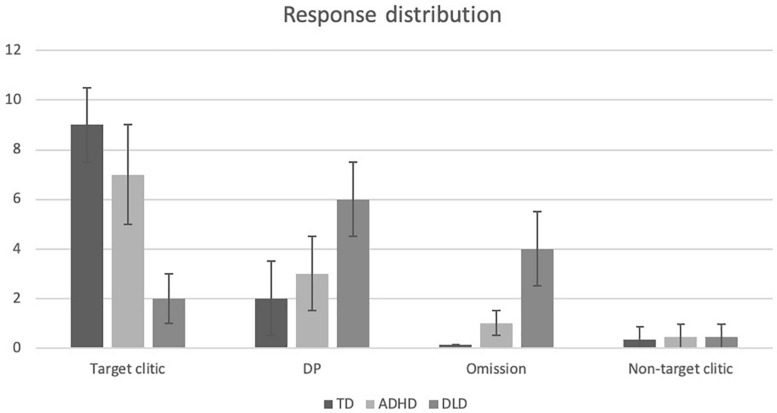
Response distribution for the probe test.